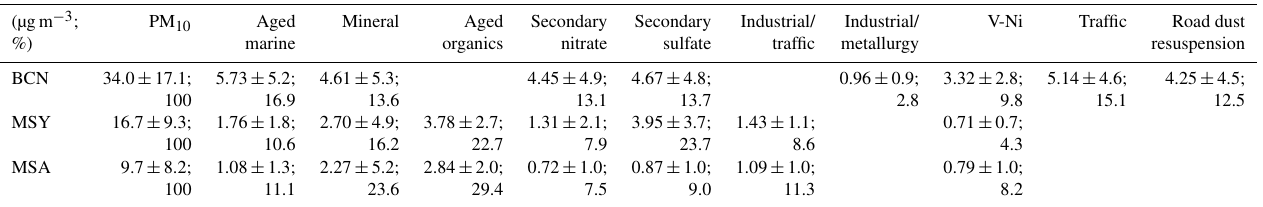
Figure 2. (a) Source chemical profiles and (b) source contributions to PM 10 mass concentration obtained at MSA by means of the PMF model. PM 10 average concentration, and absolute (µgm − 3 ) and relative (%) source contributions are reported for the study period (2010– 2014). Table 1. Absolute (µgm − 3 ) and relative (%) average source contribution to PM 10 at BCN and MSY during the period 2004–2014 (Pandolfi et al., 2016) and for MSA during the period